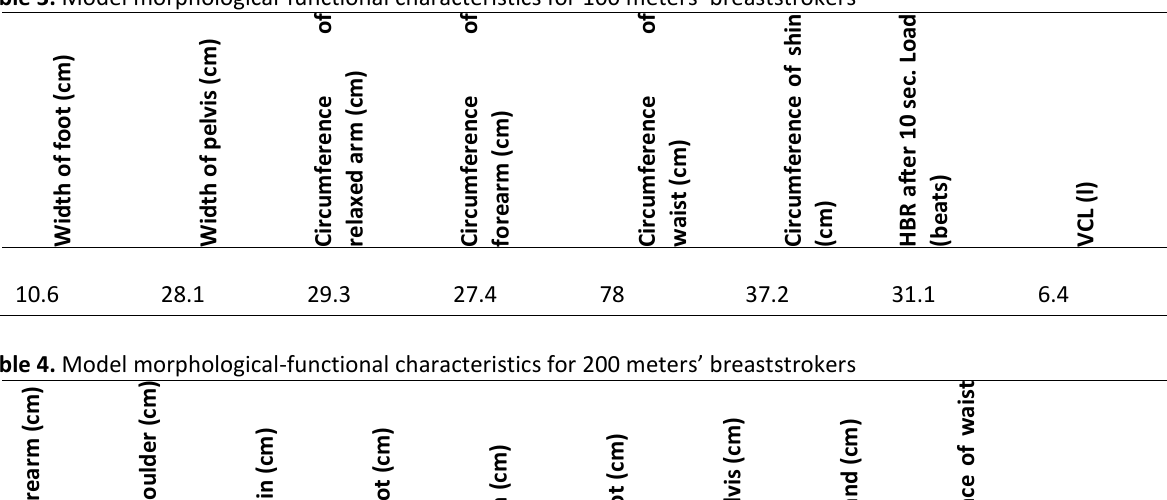
Table 3. Model morphological-functional characteristics for 100 meters’ breaststrokers